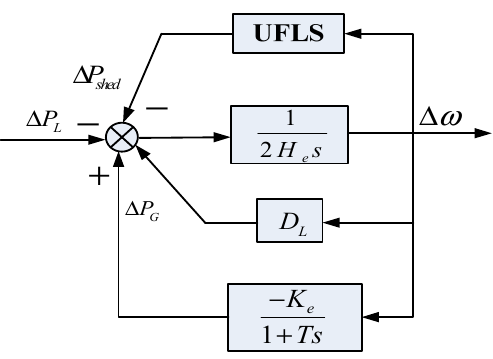
Figure 6. Structure of the simplified SFR model with UFLS.